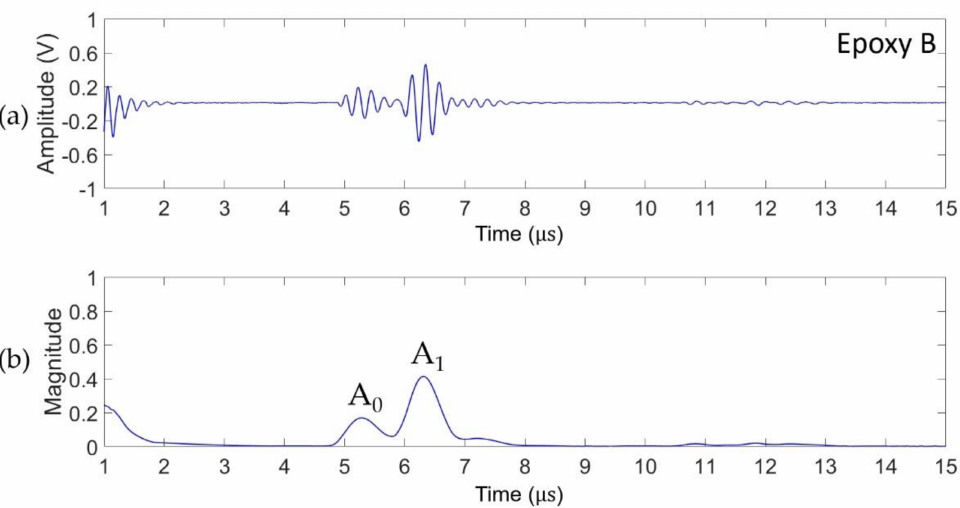
Figure 5. Epoxy B coating (thickness less than 1.5 mm): ( a ) time-domain waveform and ( b ) the projection of the STFT.